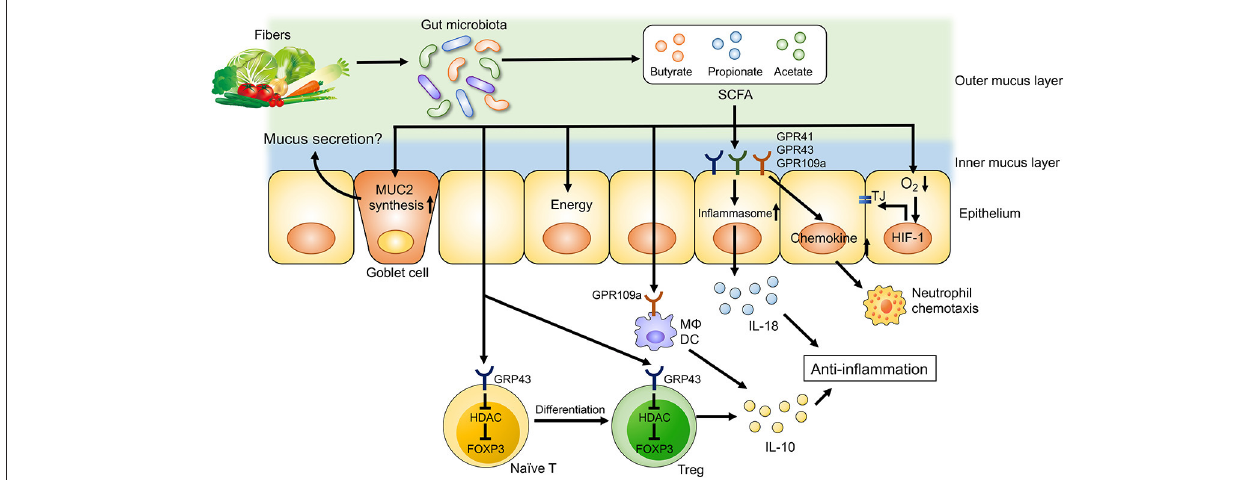
FIGURE 2 | Dietary fiber-derived SCFAs regulate intestinal homeostasis. Dietary fiber-derived SCFAs serve as energy substrates for colonocytes. Likewise, SCFAs regulate intestinal barrier function and immune system through GPCRs signaling. SCFAs promote the differentiation into Treg cells and the production of IL-10 from Treg cells through GPR43. SCFA facilitate inflammasome activation in colonic epithelial cells through GPR43, resulting in an IL-18 production that is critical for anti-inflammation and epithelial repair. SCFAs also regulate intestinal barrier function via enhancing the expression of tight junction proteins and the synthesis of